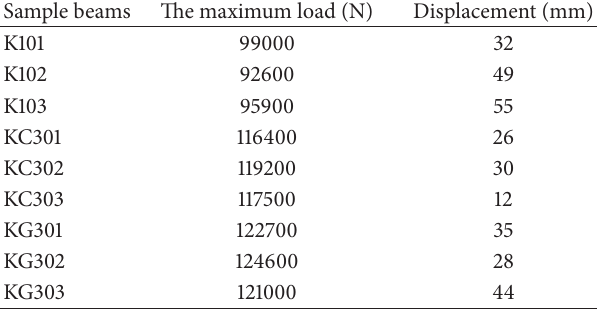
Table 5: Displacement values of each beam against the maximum load.